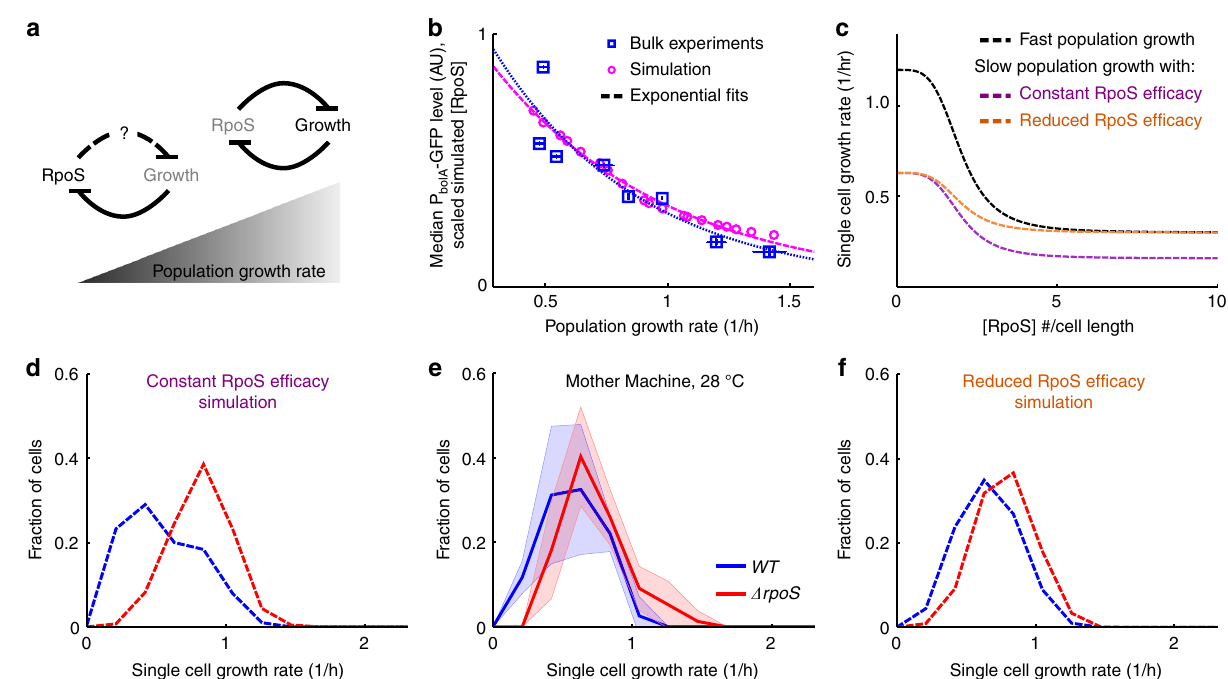
Fig. 3 RpoS levels increase, but are less potent, at reduced population growth rate. a Schematic illustrating effect of reduced population growth rate. RpoS is concentrated due to lower dilution by growth rate. However, its effect on growth rate could diminish at low population growth rate. b Median P bolA - GFP (RpoS) levels in liquid culture (±std dev smaller than data point square, mean growth rate ± std dev, at least two biological replicates, see Supplementary Table 3 for details) and scaled RpoS concentration from simulations as functions of population growth rate. Dashed lines are exponential fi ts. Scaling factor (0.32) was found by minimising root-mean-square error between the fi ts over the range of observed growth rates ± 20% (0.29 to 1.6/h). c Hill functions of growth rate as functions of RpoS concentration used in simulations. Fast population growth corresponds to simulation matching experimentally observed growth rate at 37 °C (Fig. 2e, i). The constant and reduced ef fi cacy models behave differently in the large RpoS concentration limit as population growth rate is reduced. d – f Growth rate histograms for WT and Δ rpoS . e Cells grown at reduced temperature, 28 °C, in the Mother Machine (mean ± std dev, WT , 4 technical replicates drawn from three biological replicates, 77 mother cells; Δ rpoS , 4 tech. reps. drawn from 2 bio. rep., 77 mother cells). Simulation results at corresponding population growth rate with constant RpoS ef fi cacy ( d ) and reduced RpoS ef fi cacy ( f ) (100 simulations for 19 values of g max , sampled every 24 h, in the fi nal 250h of 500 h